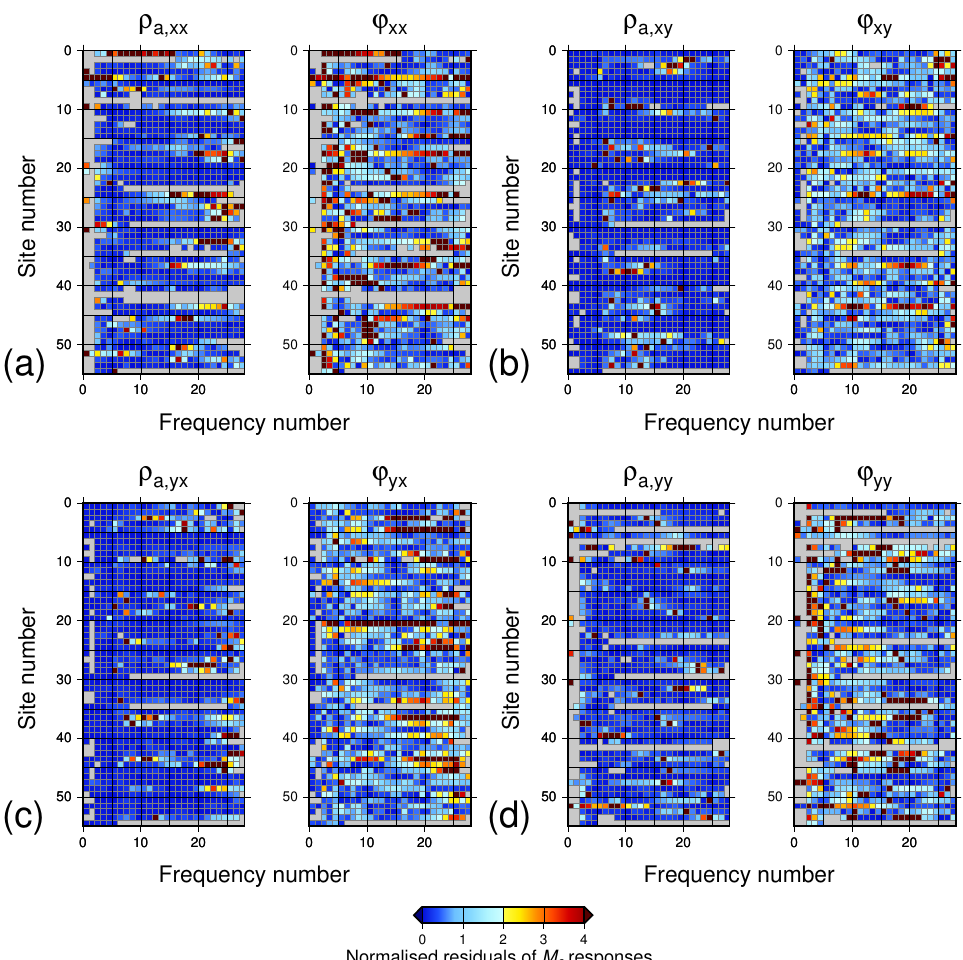
Figure 16. Visualisation of the normalised residuals of the magnetotelluric responses of M c compared to observed data at each site (numbered as per Fig. 1) and inversion frequency number (as shown in Fig. 10) for each element of the impedance tensor (a–d) . The normalised residual is determined by taking the absolute value of the difference between model response and datum and normalised by the error used in inversion (i.e. the greater of the observed errors or the applied error floor). Normalised residuals of less than 1 indicate a residual smaller than the error. Note that misfits of apparent resistivity use the logarithmic difference to determine the residual. Values in grey represent the lower-quality data that were masked and not included in the